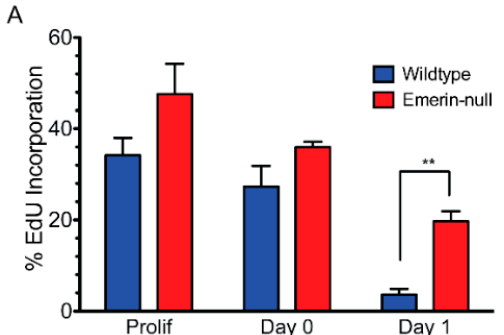
Figure 1. Cont Figure 1. Cont.